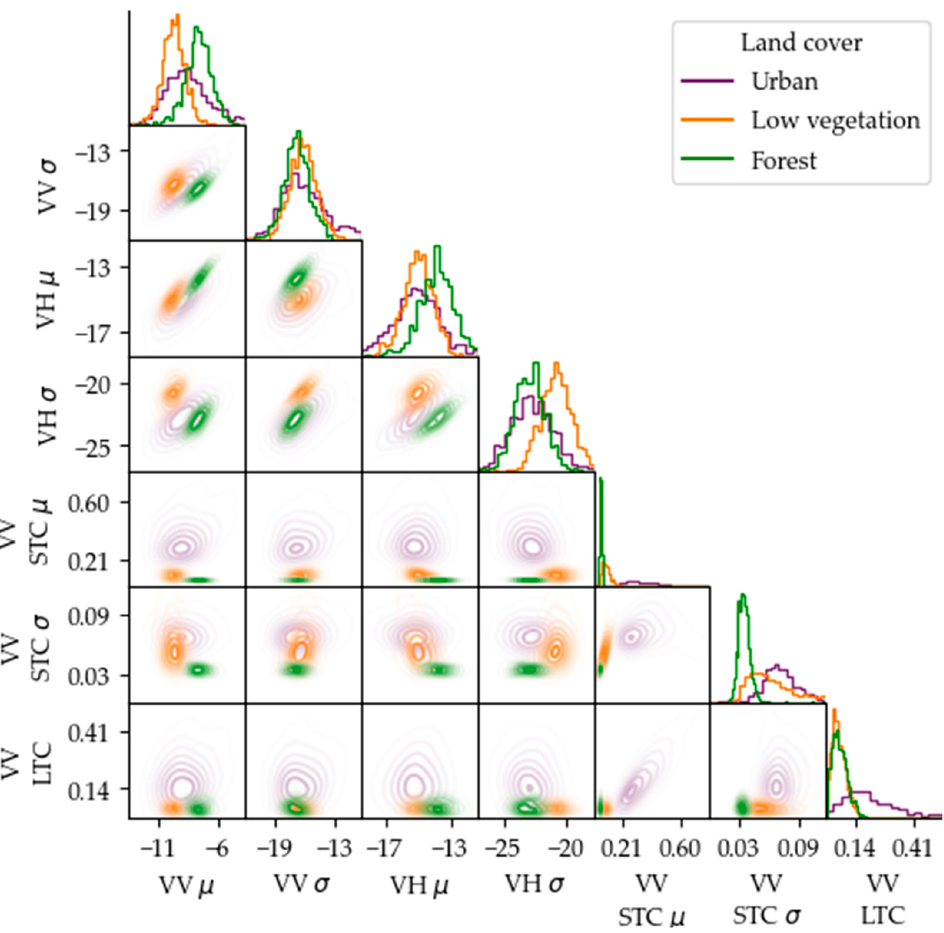
Figure 4. Value distribution of a subset of 1000 random pixels extracted from the training sample at the tropical site. The diagonal displays the histograms, whereas the rest of cells display the 2D kernel density plots for each pair of variables. Water cover has been excluded to better display the distribution overlap for the rest of classes. STC stands for “short-term coherence” whereas LTC stands for “long term coherence”. Note that backscattering intensity annual statistics were calculated in linear scale and then converted to decibel (dB).